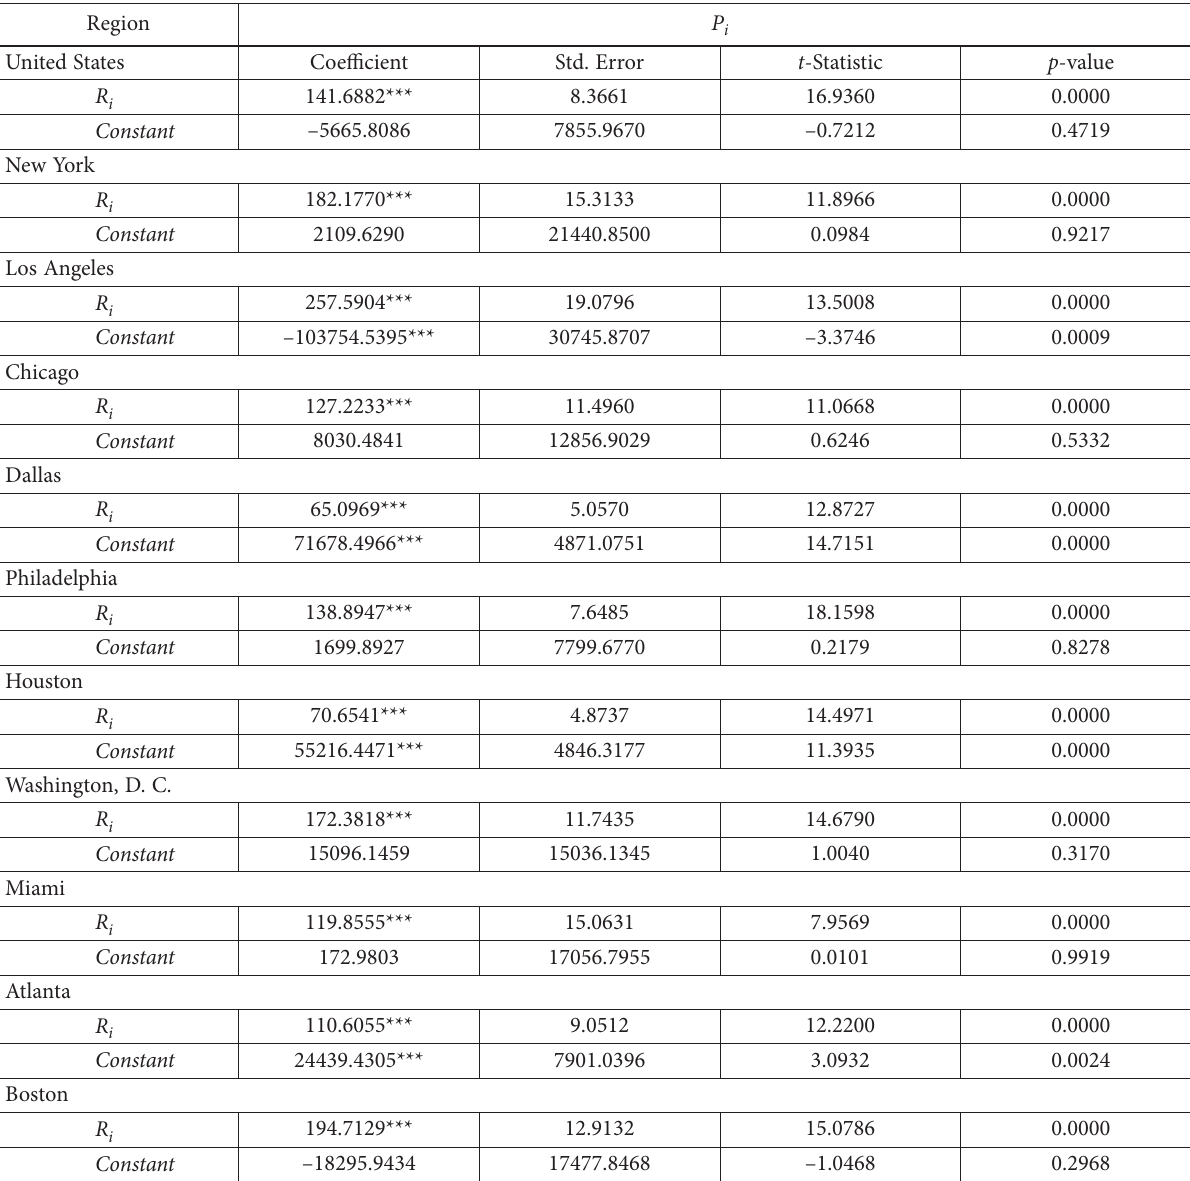
Table 4. Results of FMOLS